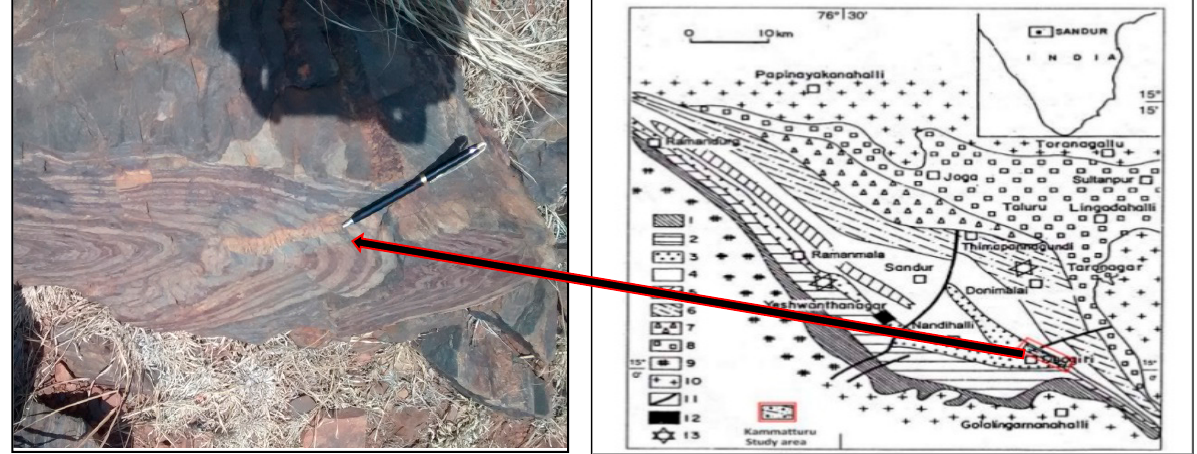
Figure 1. Sample collection point and geological site location of Kumaraswamy Range, Sandur (Source: [12]).